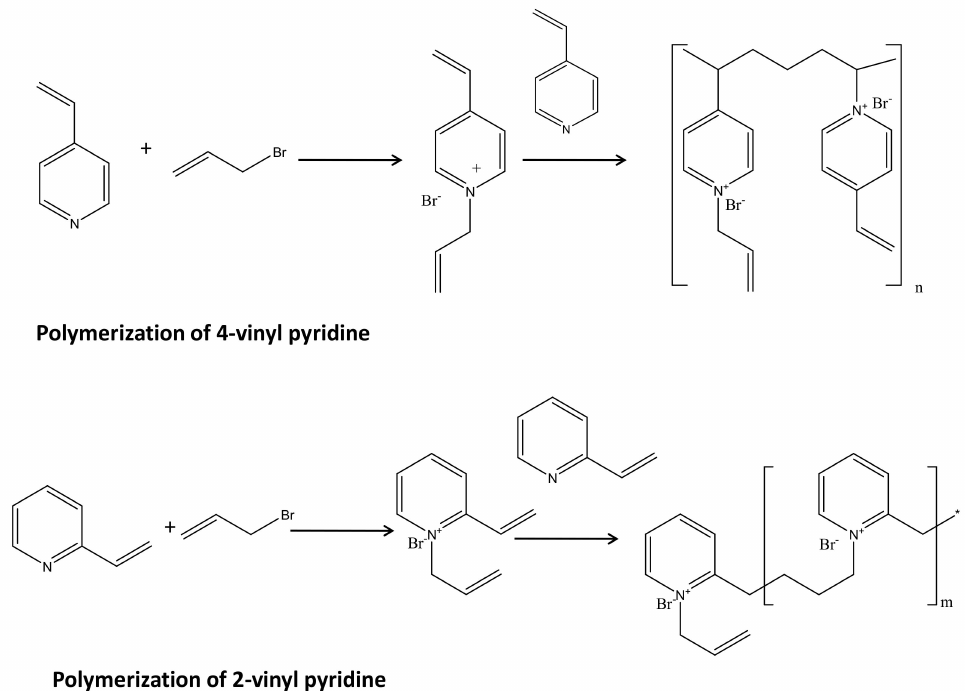
Figure 1. The schematic presentation of preparation of poly(ionic